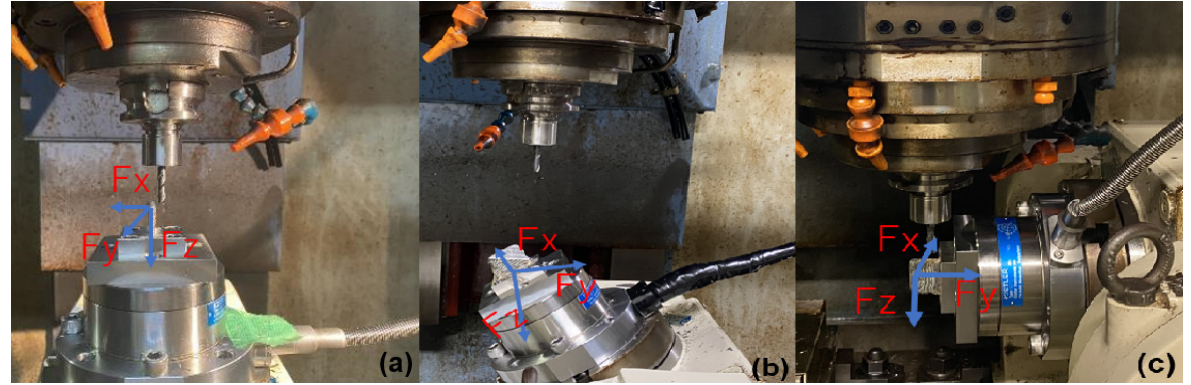
Figure 1. Machining Procedure Setup. Cuttings angles of ( a ) 0 degrees, ( b ) 35 degrees, and ( c ) 90